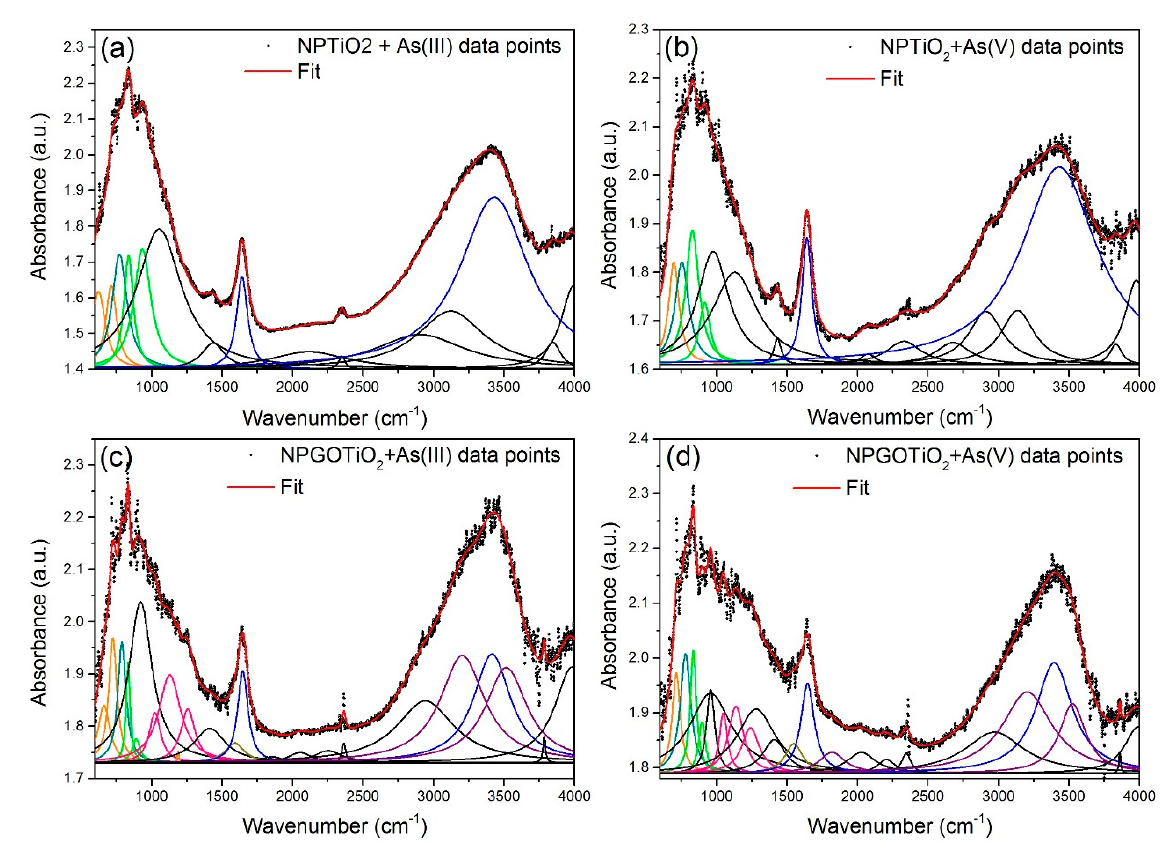
Figure 7. Fitted FTIR spectra of the NPTiO 2 in ( a ) As (III) and ( b ) As (V) solutions, and NPGOTiO 2 in ( c ) As(III) and ( d ) As(V) solutions. In the graphs, the orange color indicates the Fe-O stretching mode, the dark cyan is due to Ti-O, the green color to As-O, the pink color to C-O, the dark yellow to C=C, the blue color to O-H, the purple color to C-OH and COOH groups, and the black represents the background contribution. Figure developed by the authors. Table 3. Position centers of main modes of vibration. This table was developed from data of the IR spectra shown in Figures 6 and